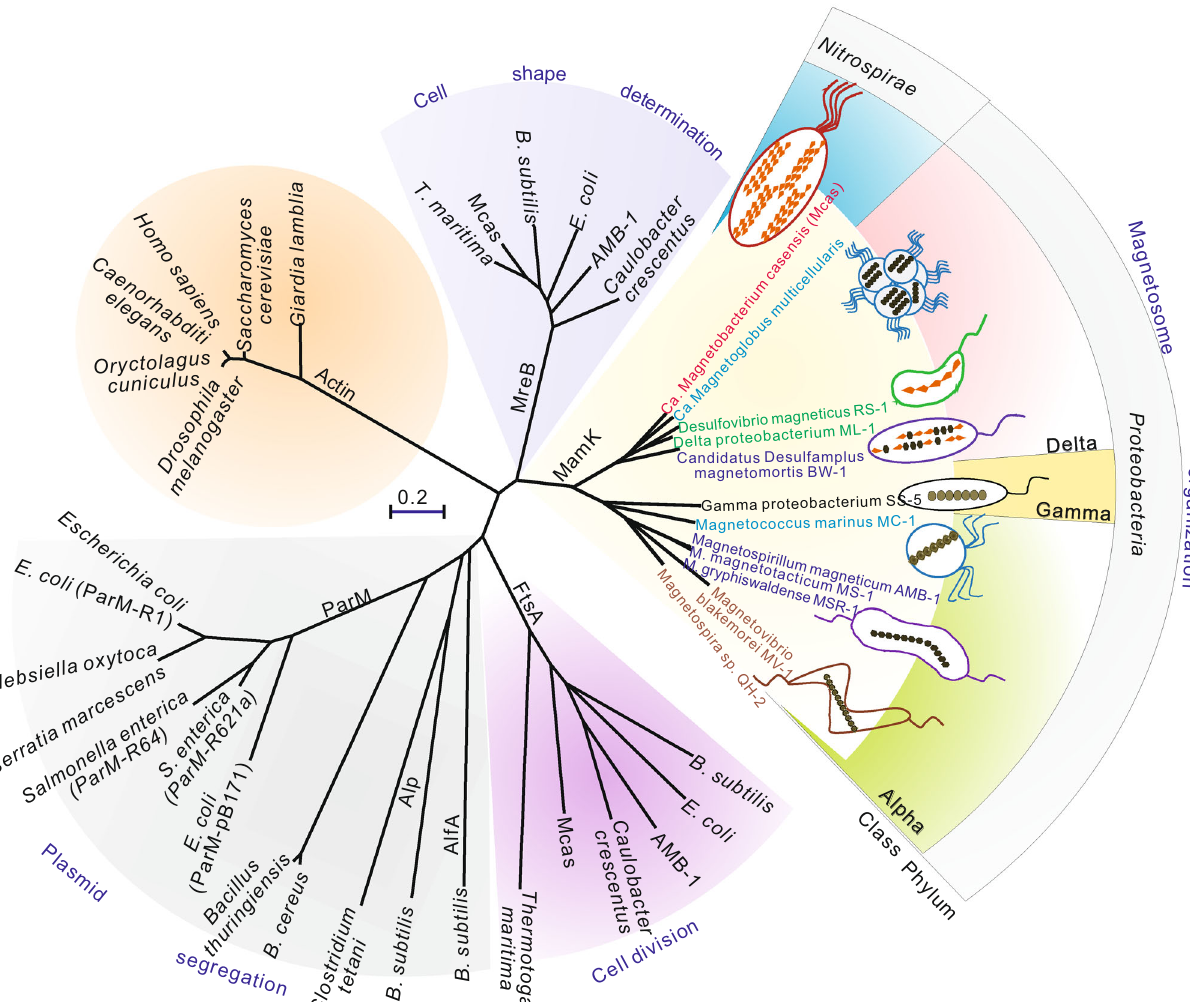
Figure 1. Phylogenetic tree based on amino acid sequences of actin-like and closely related proteins found in bacteria. The eukaryotic actin proteins from distinct sources including Saccharomyces cerevisiae , Caenorhabditis elegans , Giardia lamblia , Drosophila melanogaster , Oryctolagus cuniculu and Homo sapiens were used to root the tree. The MamK proteins from cultured and uncultured magnetotactic bacteria that have known magnetosome structures clustered into two groups. Accession numbers are given in Table S1. The tree is based on a maximum likelihood algorithm. The bar represents 20% sequence